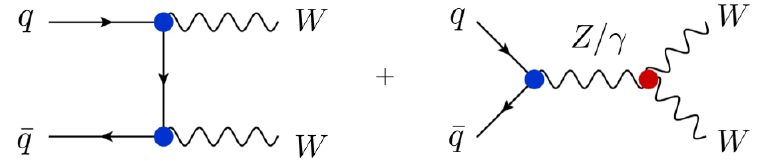
Figure 1 . Representative contributions to diboson production. The sensitivity of the measure- ments, already with O (20) fb (cid:0) 1 of data and certainly even more at HL-LHC, is such that they can improve the LEP-1 constraints on the quark couplings to gauge bosons (blue). This also implies that the LEP-1 bounds are no longer stringent enough to make these parameters negligible when setting bounds on the anomalous triple gauge couplings